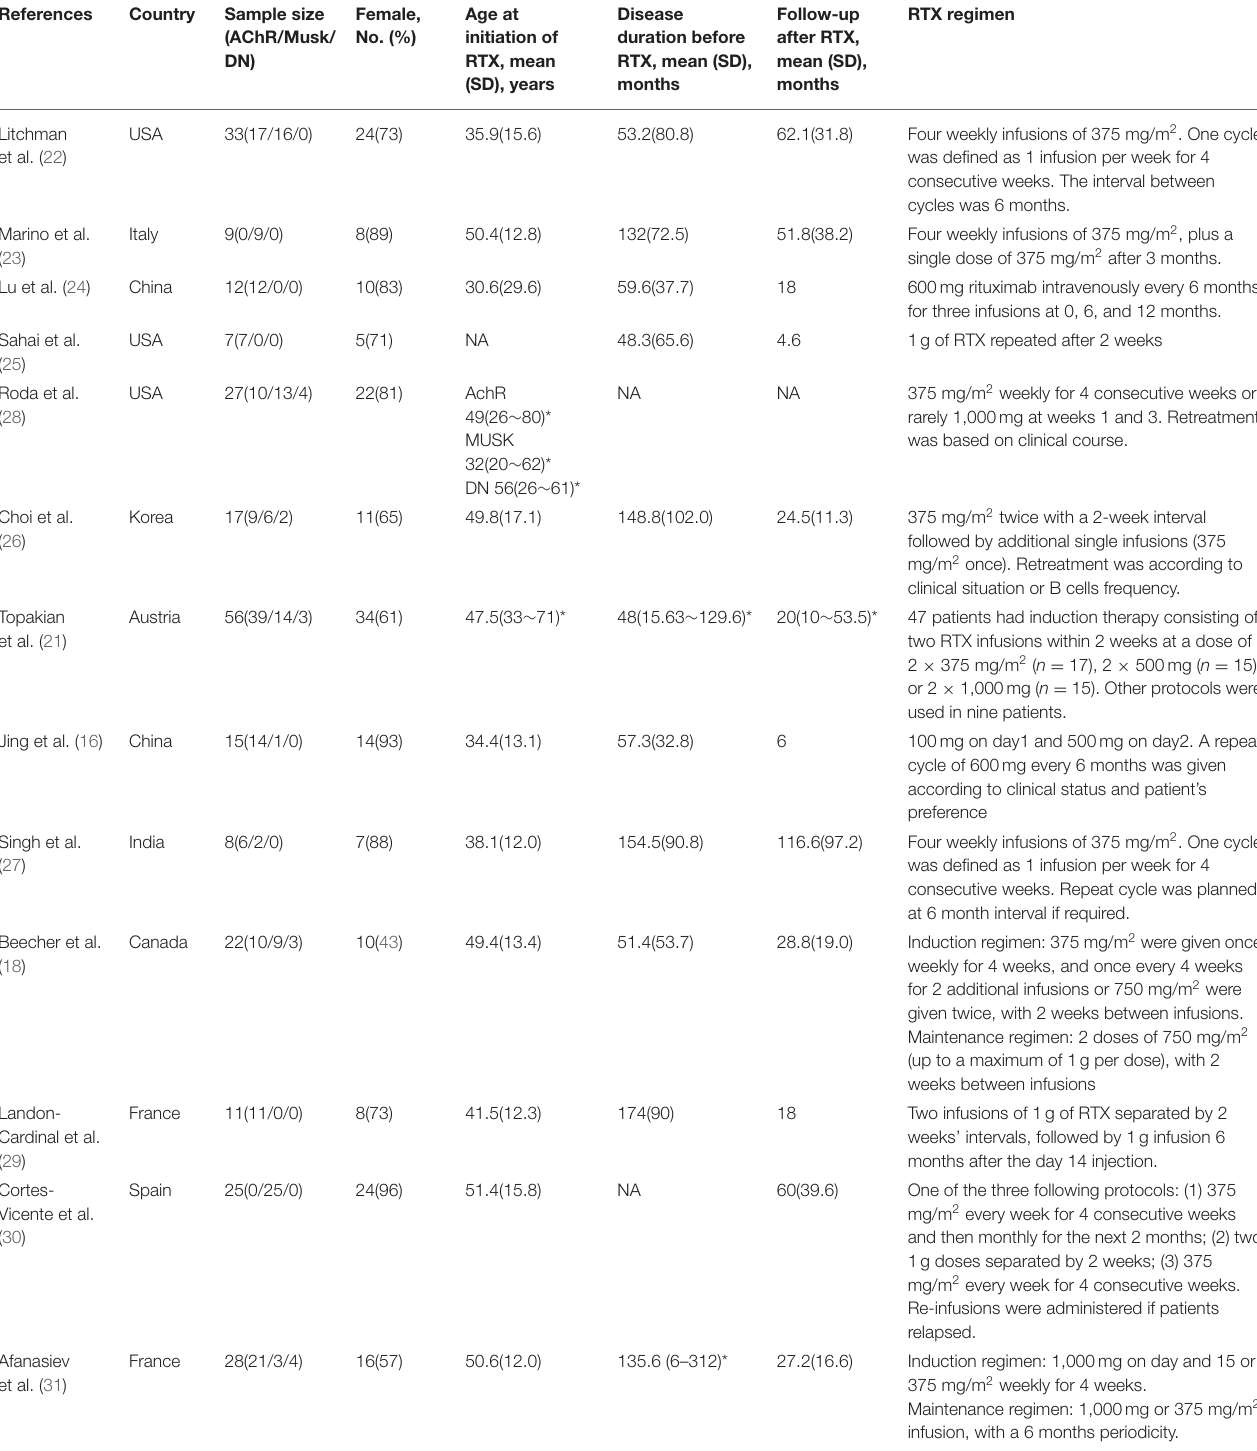
TABLE 1 | Baseline characteristics of studies included in the